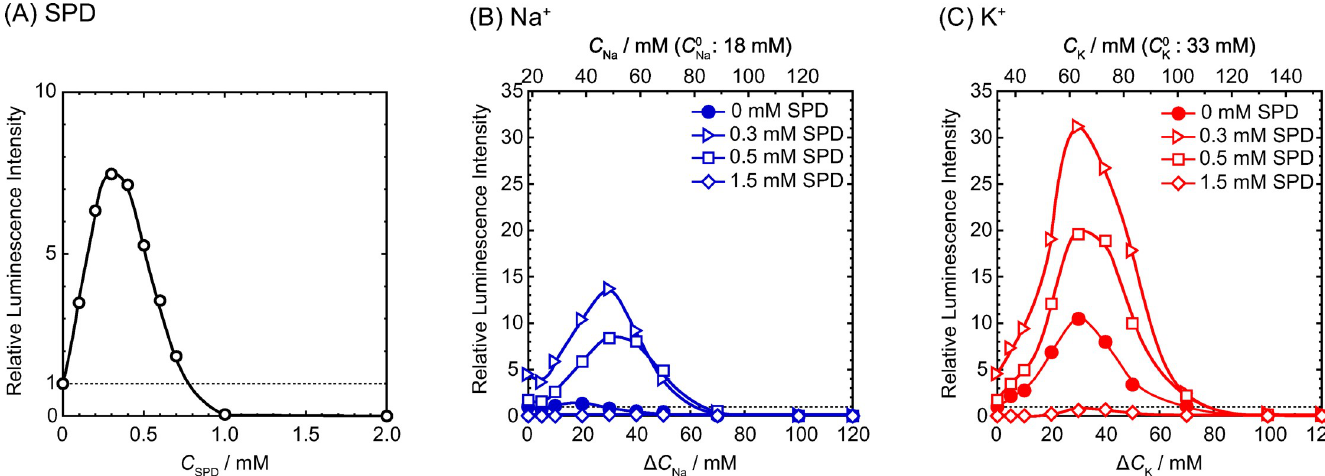
Fig 1. Efficiency of gene expression vs. concentrations of (A) SPD, (B) Na + and (C) K + . C 0 is the concentration of Na + and K + contained in the original reaction buffer; C = C 0 + Δ C . The intensity is normalized to the control condition (= 1), where Δ C = 0 in the absence of SPD. The DNA concentration was fixed at 0.3 μ M.